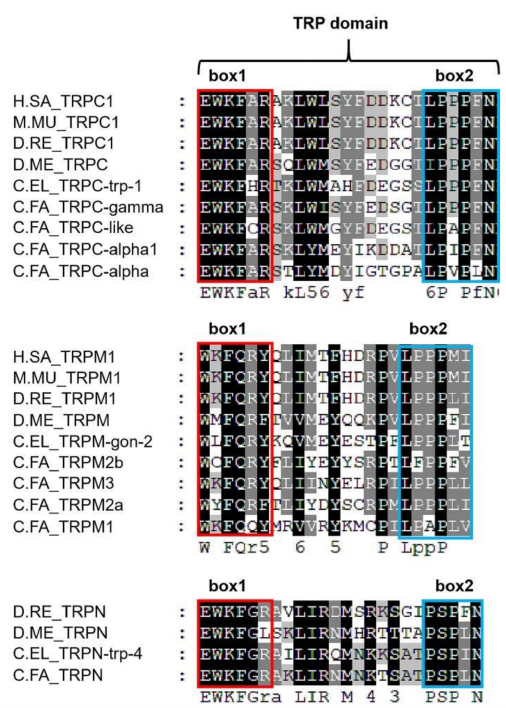
Figure 2. Multi-sequence comparison of the TRP domain in TRPC, TRPM and TRPN. Box 1 frames with red and box 2 frames with blue. H.SA, H. sapiens ; M.MU, M. musculus ; D.RE, D. rerio ; D.ME, D. melanogaster ; C.EL, C. elegans ; C.FA , C. farreri